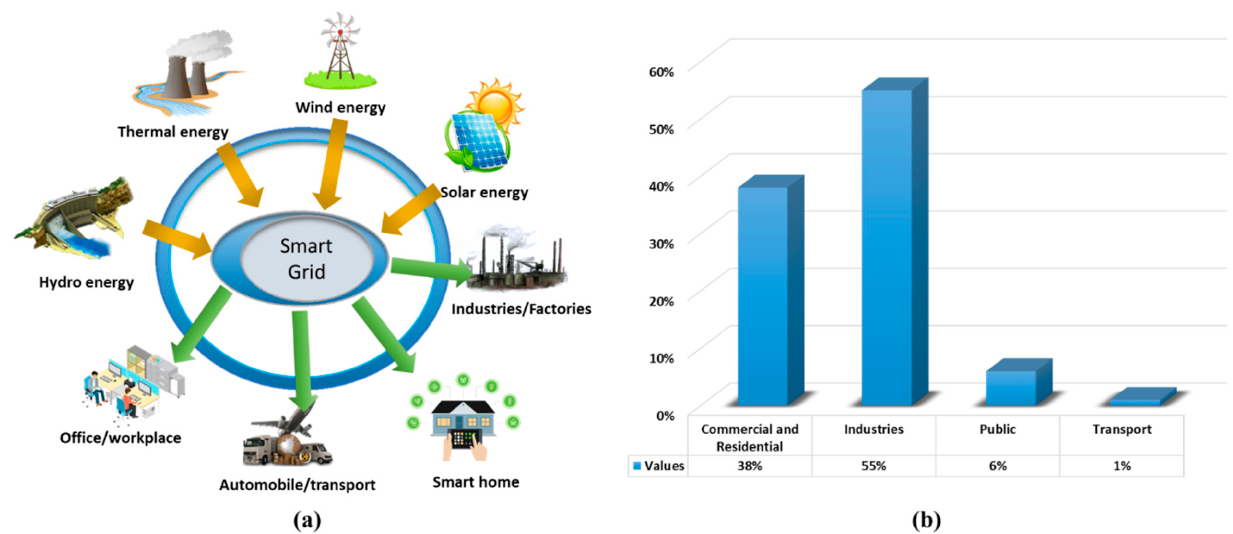
Figure 1. Overview of a smart grid operation and the statistical details energy consumption in different sectors. ( a ) Renewable energy is obtained by the smart grid, where it is organized and made suitable for usage. After passing the data from the initial stages, it is supplied to the consumers according to their demands. These consumers include industries, households, offices, and public transport systems. ( b ) The statistical overview of the energy used in different sectors of South Korea, where the industries consume huge amount of energy due to heavy machinery.